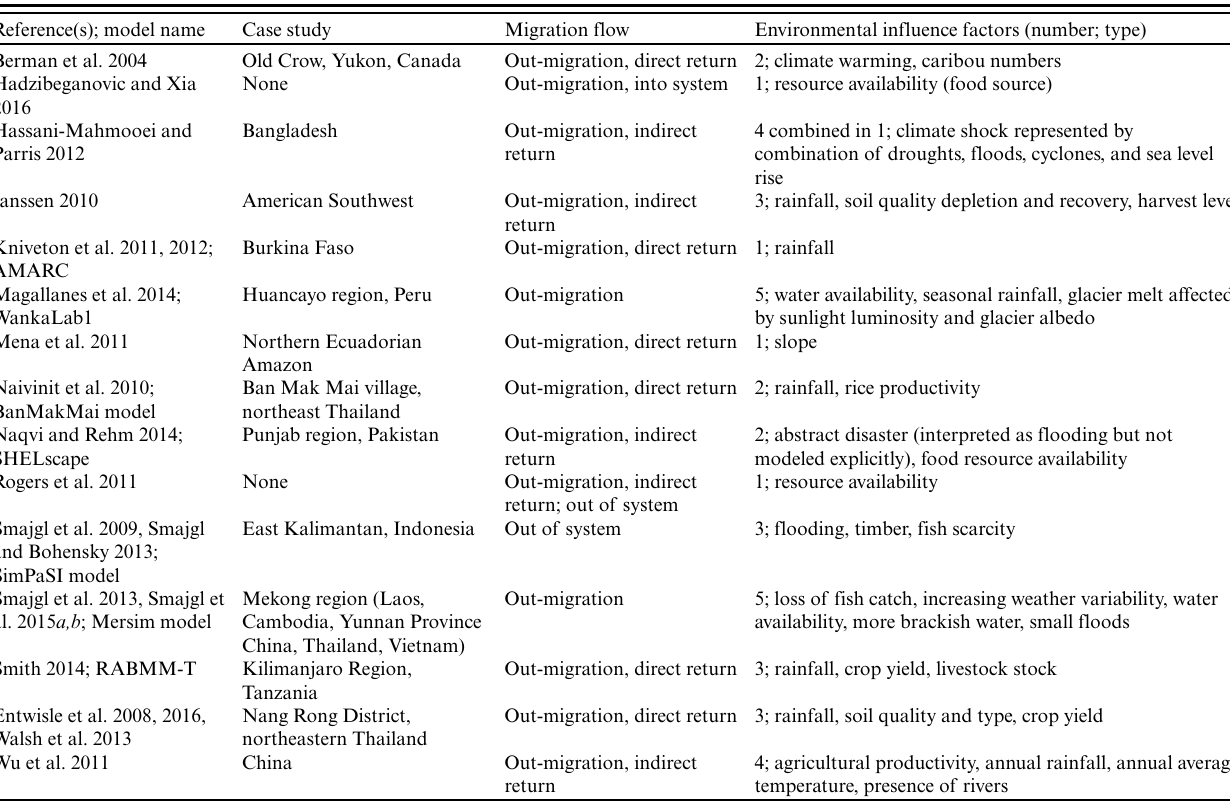
Table 3 . Summary of the reviewed agent-based models; the full categorization of each model can be found in the Appendix 1. Reference(s); model name